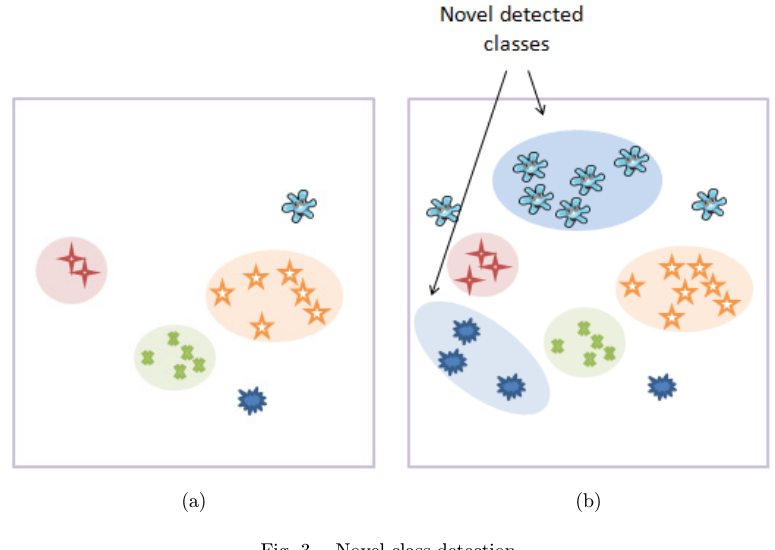
Fig. 3. Novel class